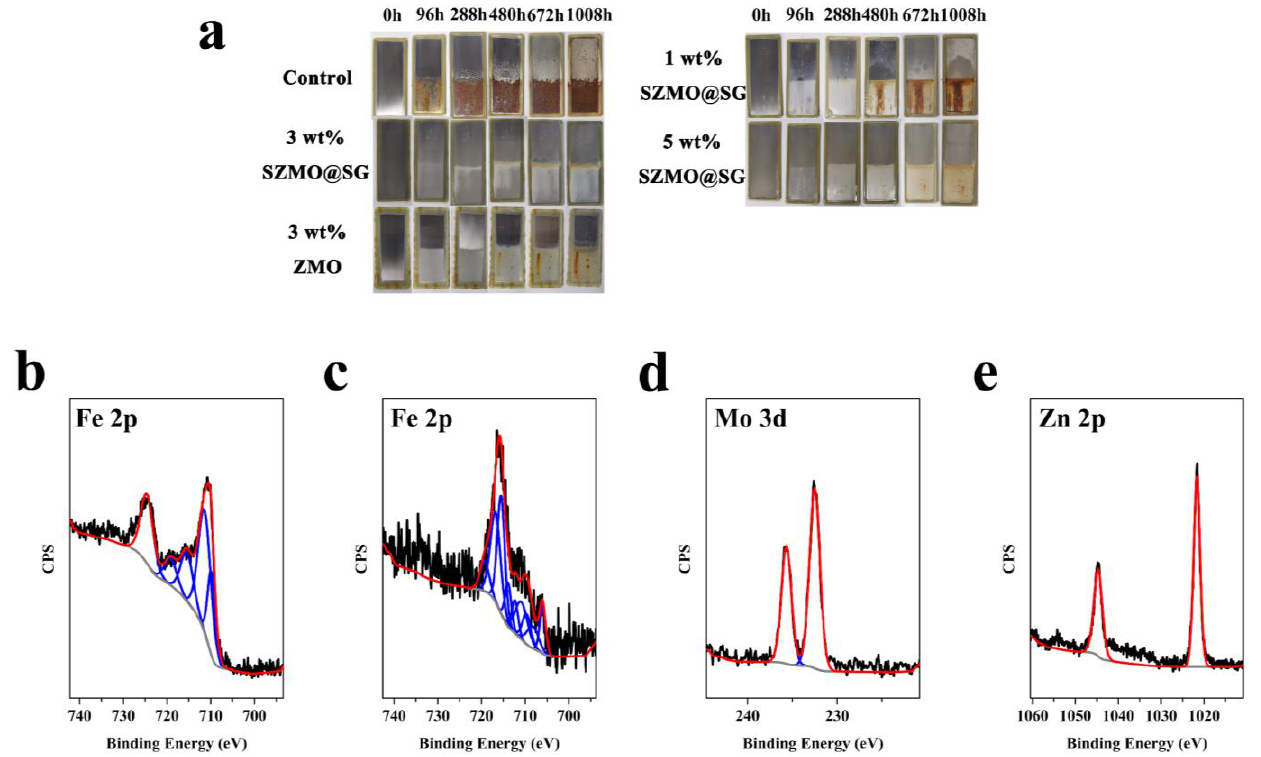
Figure 8. The images of ( a ) coating samples with 3.5 wt% NaCl solution immersion for different times and high resolution XPS spectra of Zn 2p, Mo 3d, Fe 2p of ( b ) control, ( c – e ) coatings with 3 wt% SZMO@SG immersed in 3.5 wt% NaCl solution for 1008 h.